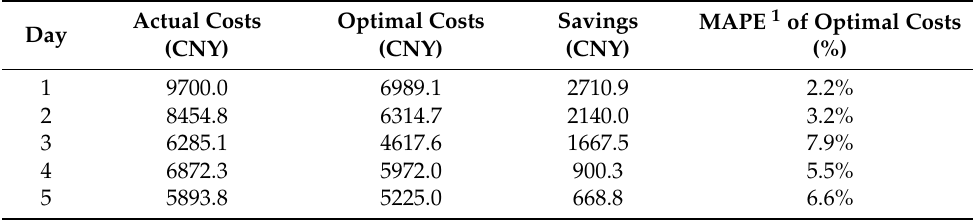
Table A7. Daily actual costs, optimal costs and their mean absolute percentage error, and savings of the case system for 59 d from 22 June to 19 August